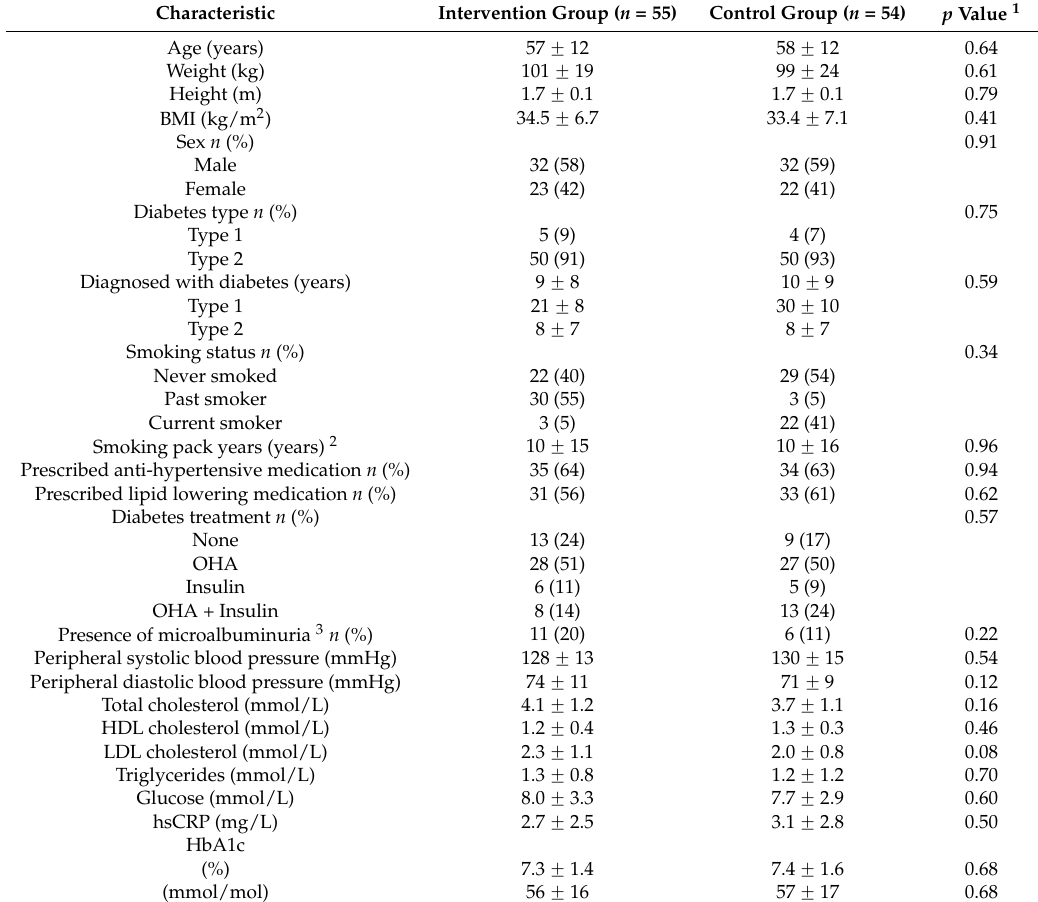
Table 1. Baseline characteristics of the participants that were